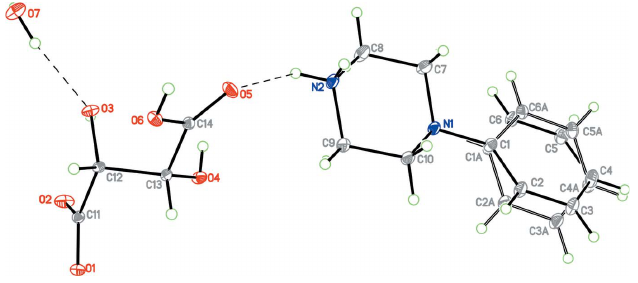
Figure 10 The molecular structure of 11 with hydrogen bonds shown as dashed lines and disorder of the phenyl ring indicated. Atomic displacement parameters are at the 30% probability